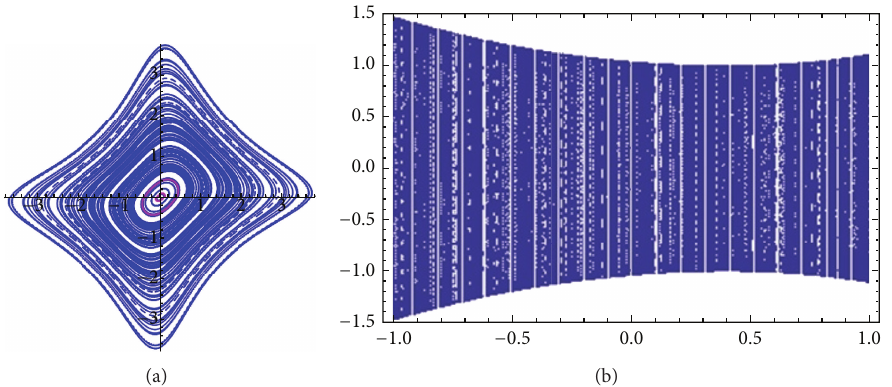
Figure 1: (a) A Phase portrait of three orbits for 𝑎 = 0.5 . (b) A bifurcation diagram of typical solution of (5) for 𝑎 between −1 and 1 . The plots are produced by Dynamica 3